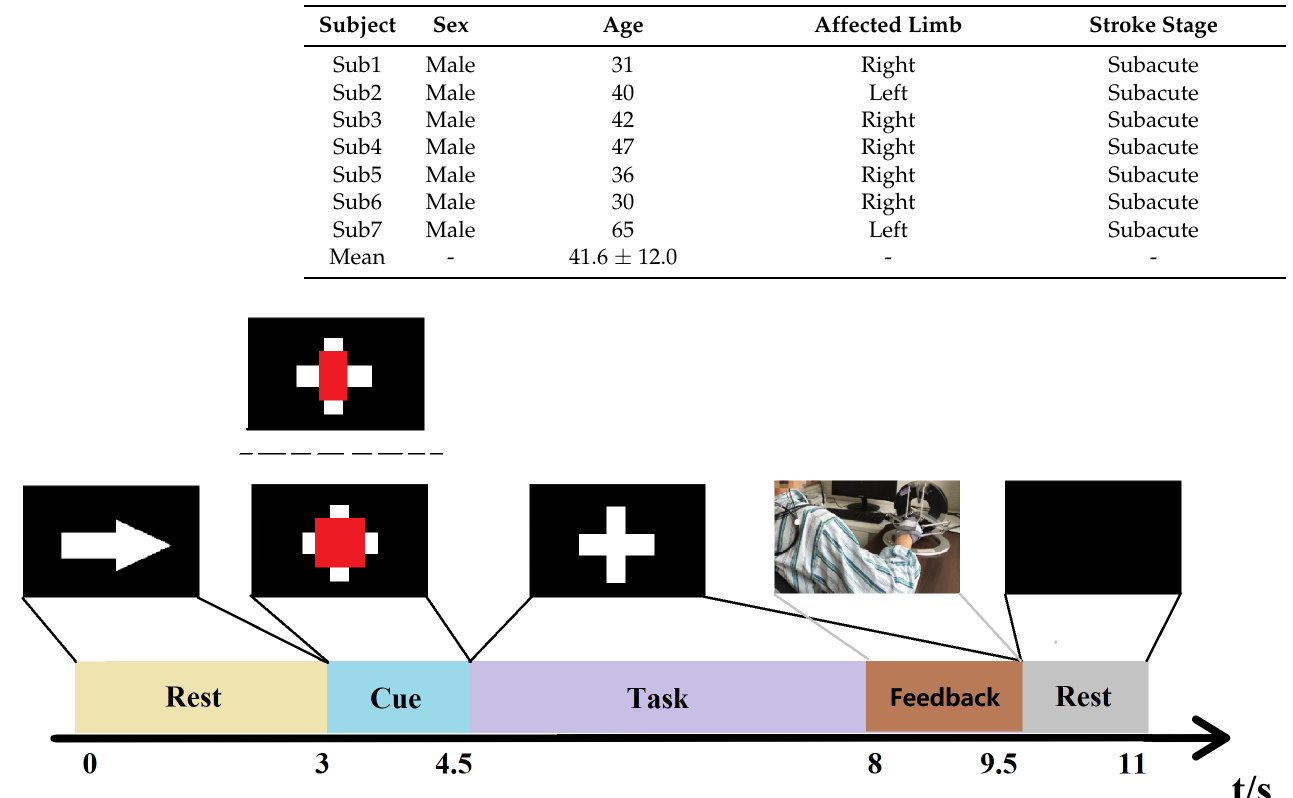
Table 1. Demographic information of the subjects.